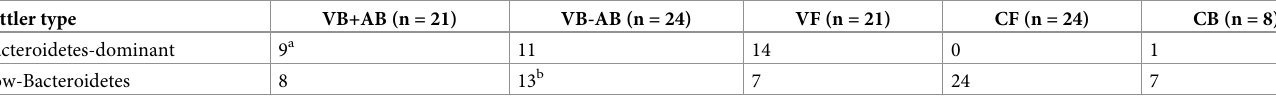
Table 2. Distribution of infants per settler